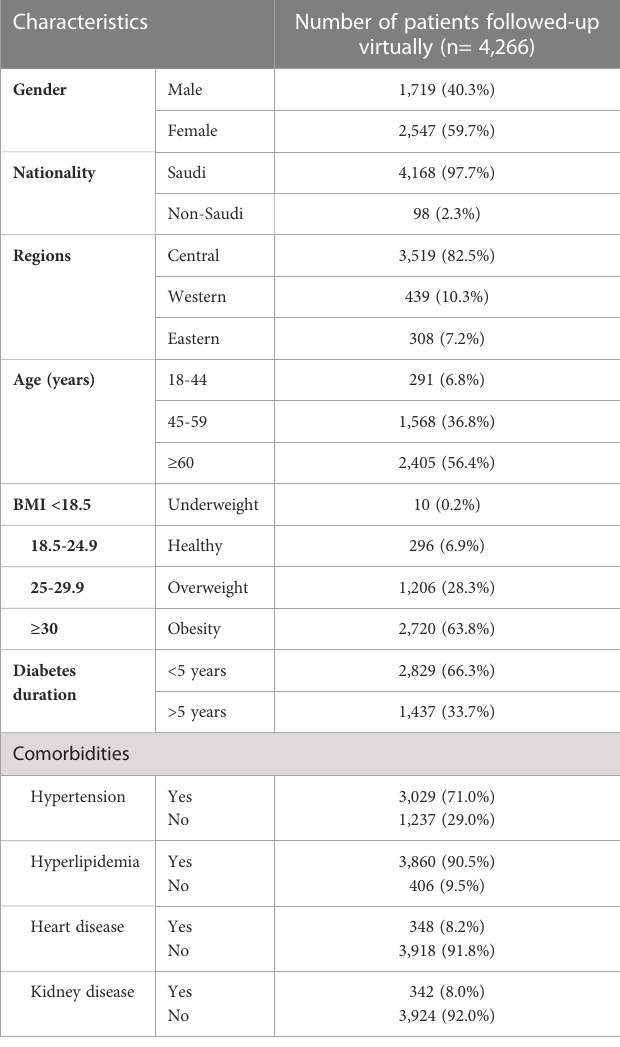
TABLE 1 Baseline demographic and clinical characteristics of recruited patients.